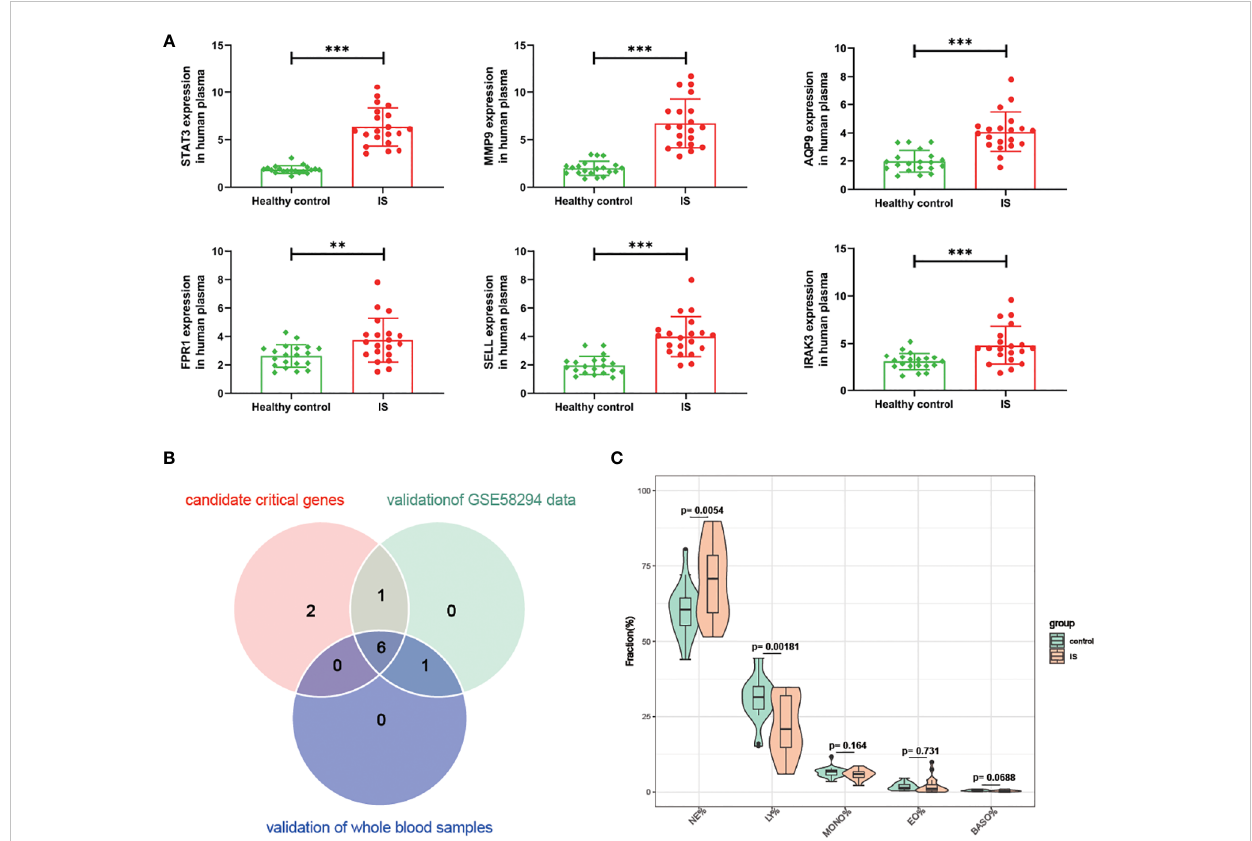
FIGURE 6 Validation for the difference of candidate critical gene expression and neutrophil percentage using clinical samples. (A) Veri fi cation for candidate critical genes using qRT-PCR analysis. (B) Venn plot of candidate critical genes and validated real critical genes. (C) Violin plot showing the difference of Neutrophils (NE), lymphocytes (LY), monocytes (MONO), eosinophils (EO) and basophils (BAAO) percentage in IS patients compared with controls. ** P value < 0.01 in the comparison between IS and healthy controls. ***P value < 0.001 in the comparison between IS and healthy